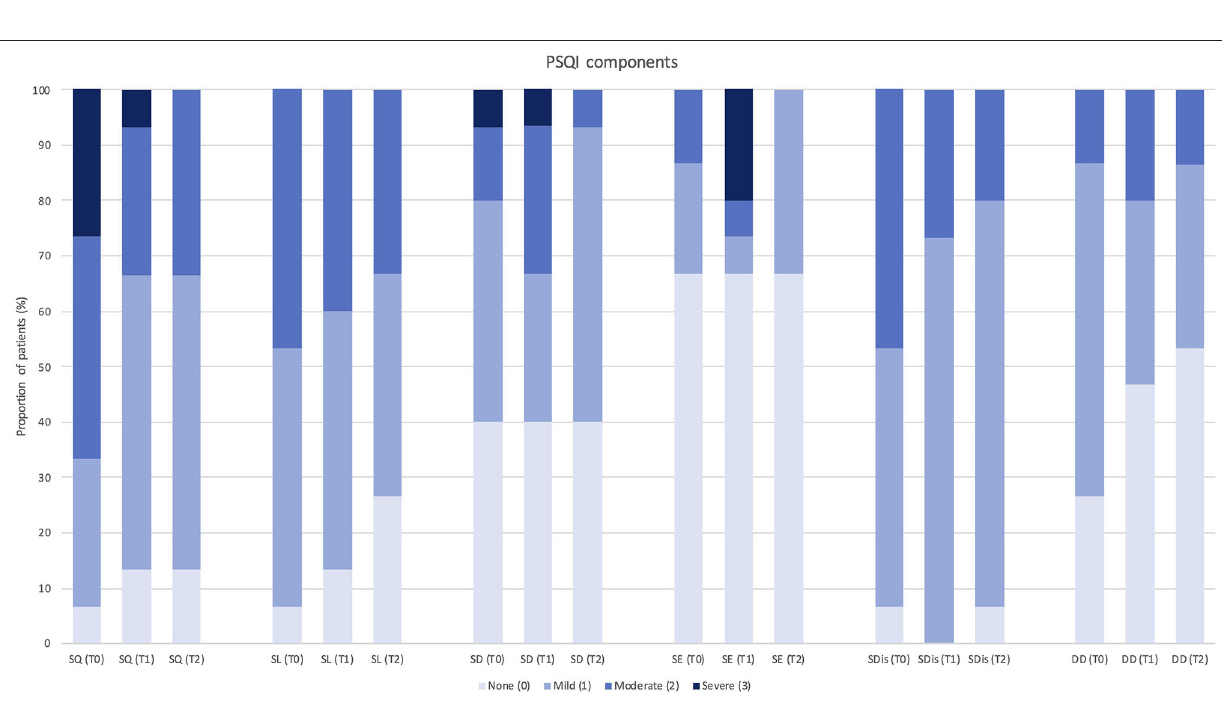
Frontiers in Neurology |